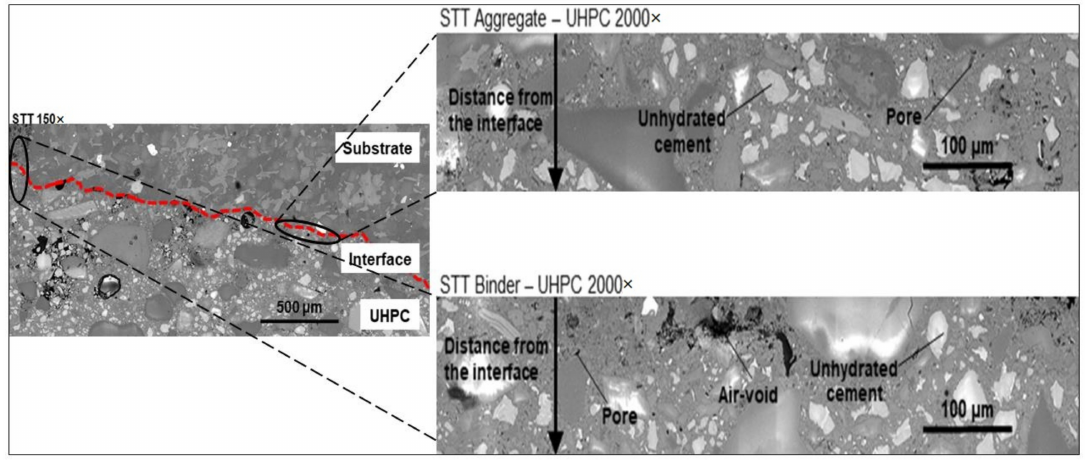
Figure 13. Interfacial bond zone of composite specimen using shuttering plywood at 150 × and 2000 ×